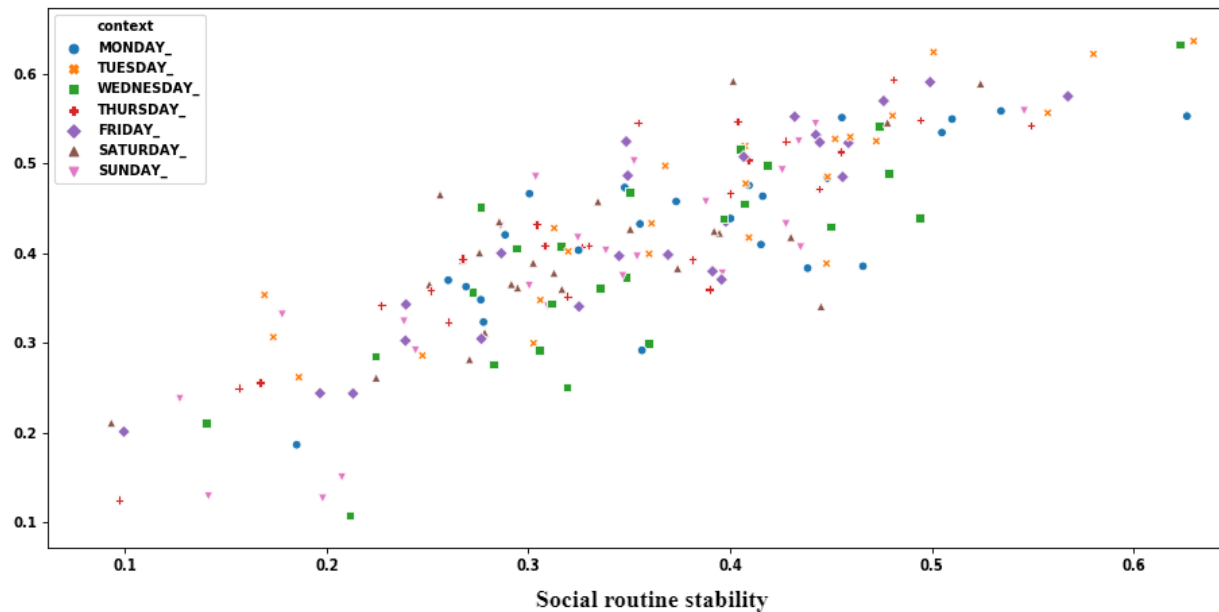
Figure 13. Correlation between prediction performance of sociability pattern and social routine